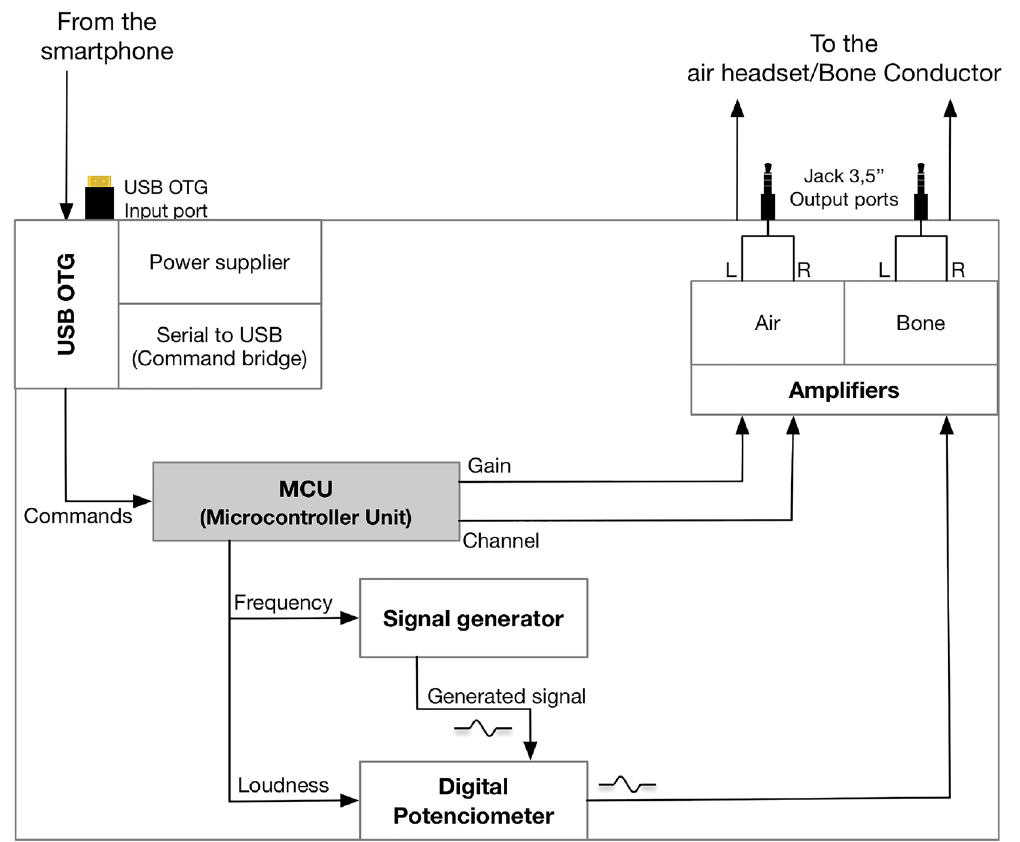
Figure 2: Components diagram of the device, interconnections and control